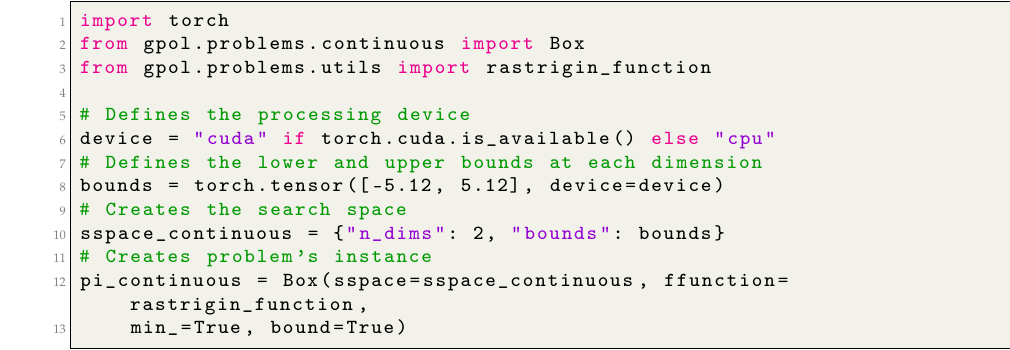
Figure A1. A demonstration of how to create an instance of the Box